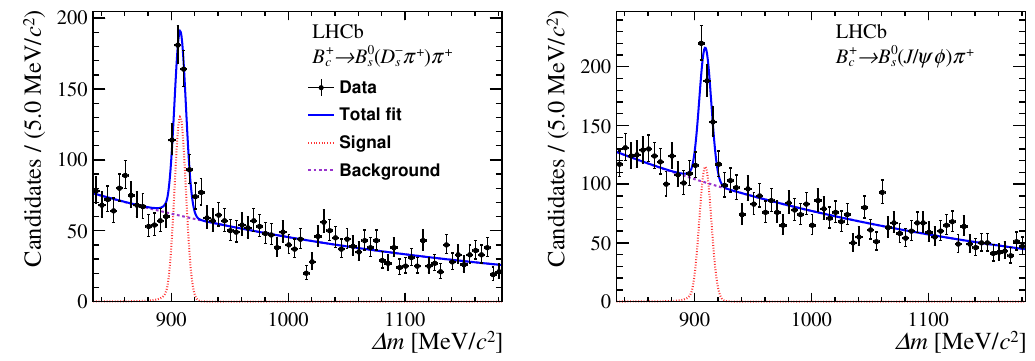
! B 0 ( D (cid:0) (cid:25) + ) (cid:25) + and B + ! c s s c